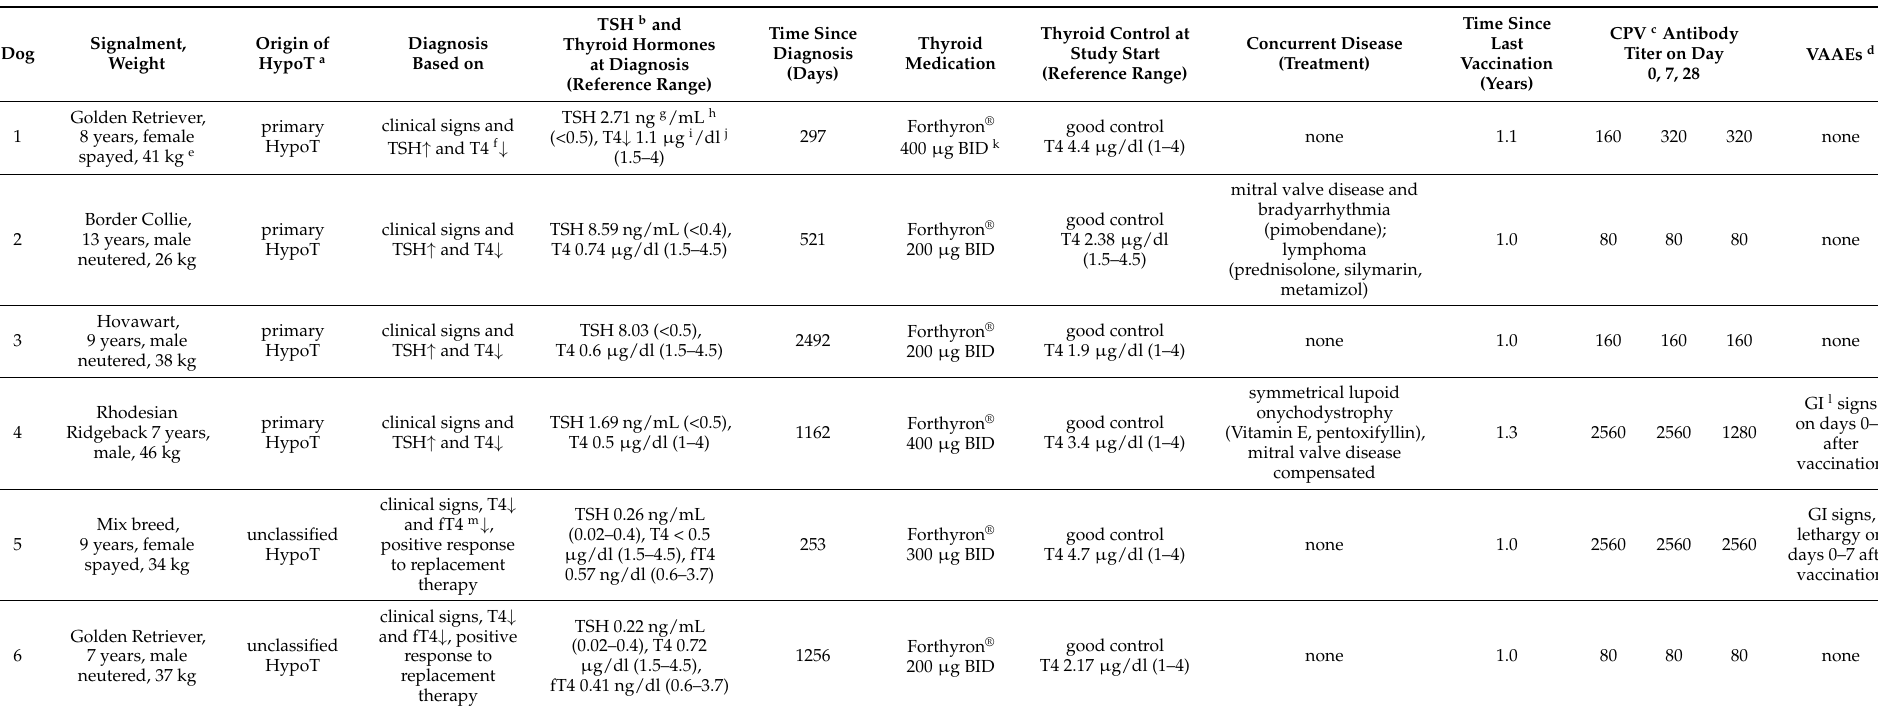
Table 1. Signalment, history, and pre-vaccination antibody titer against canine parvovirus (CPV) of the dogs with hypothyroidism (HypoT) treated with levothyroxine and their response to